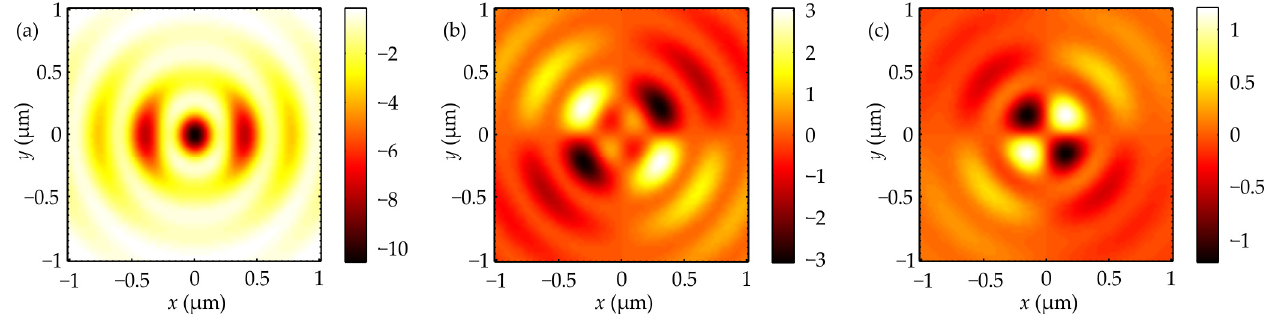
Figure 5. Stokes vector components s 1 ( a ), s 2 ( b ), and s 3 ( c ) at a distance λ before the focal plane.